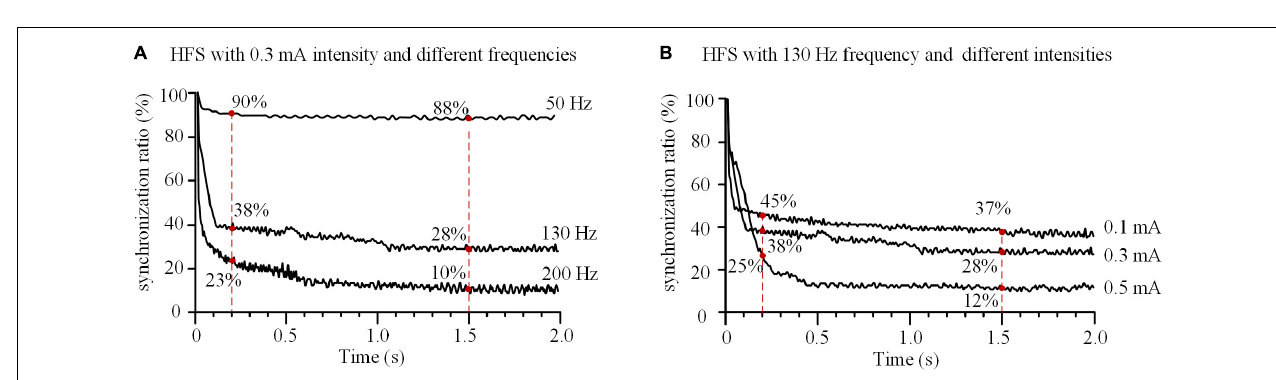
FIGURE 5 | Synchronization ratio of action potentials generated in a bundle of 11 axons during high-frequency stimulation.